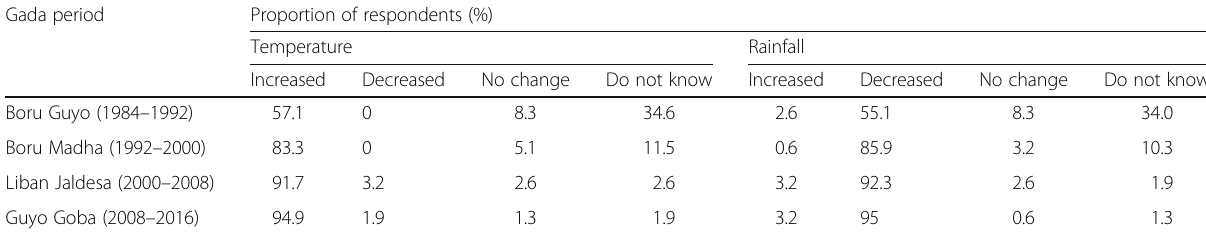
Table 1 Respondents ’ perceptions on trends of temperature and rainfall over the last four Gada periods (1984 – 2013) in Borana, southern Ethiopia Gada period Proportion of respondents (%)